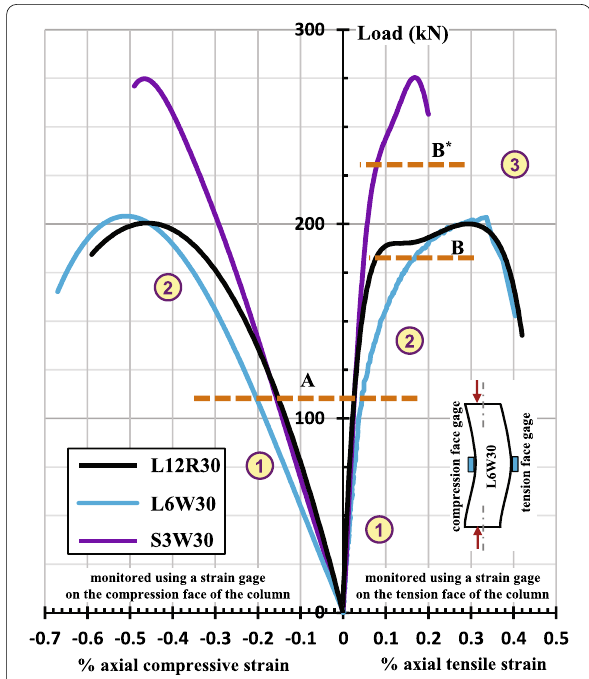
Fig. 15 Load–axial strain curves for sample columns at compression and tension